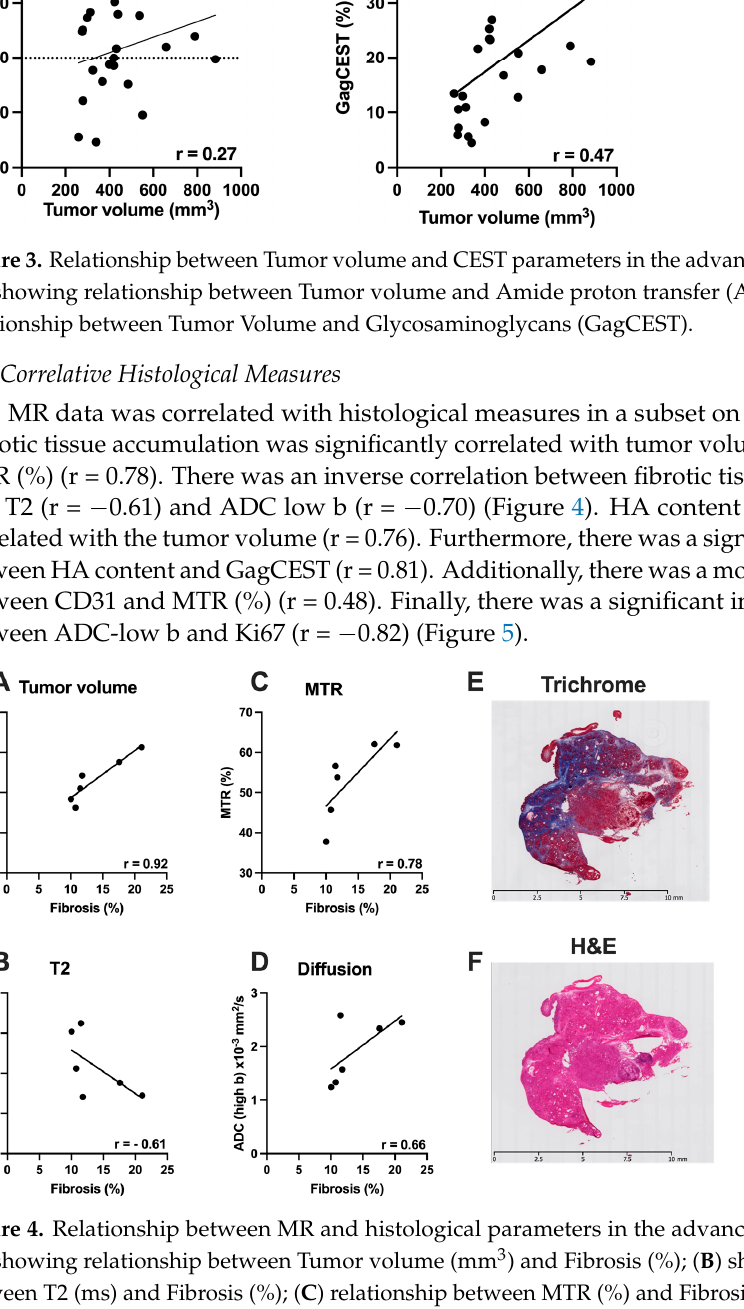
Figure 5. Relationship between MR and histological parameters in the advanced stages of PDAC. ( A ) showing relationship between Tumor volume and Hyaluronan (HA%); ( B ) showing relation- ship between GagCEST and HA (%); ( C ) relationship between MTR (%) and CD31; ( D ) ADC low b and Ki67. ( E – G ) Representative images of HA, CD31 and Ki67 stained slides.